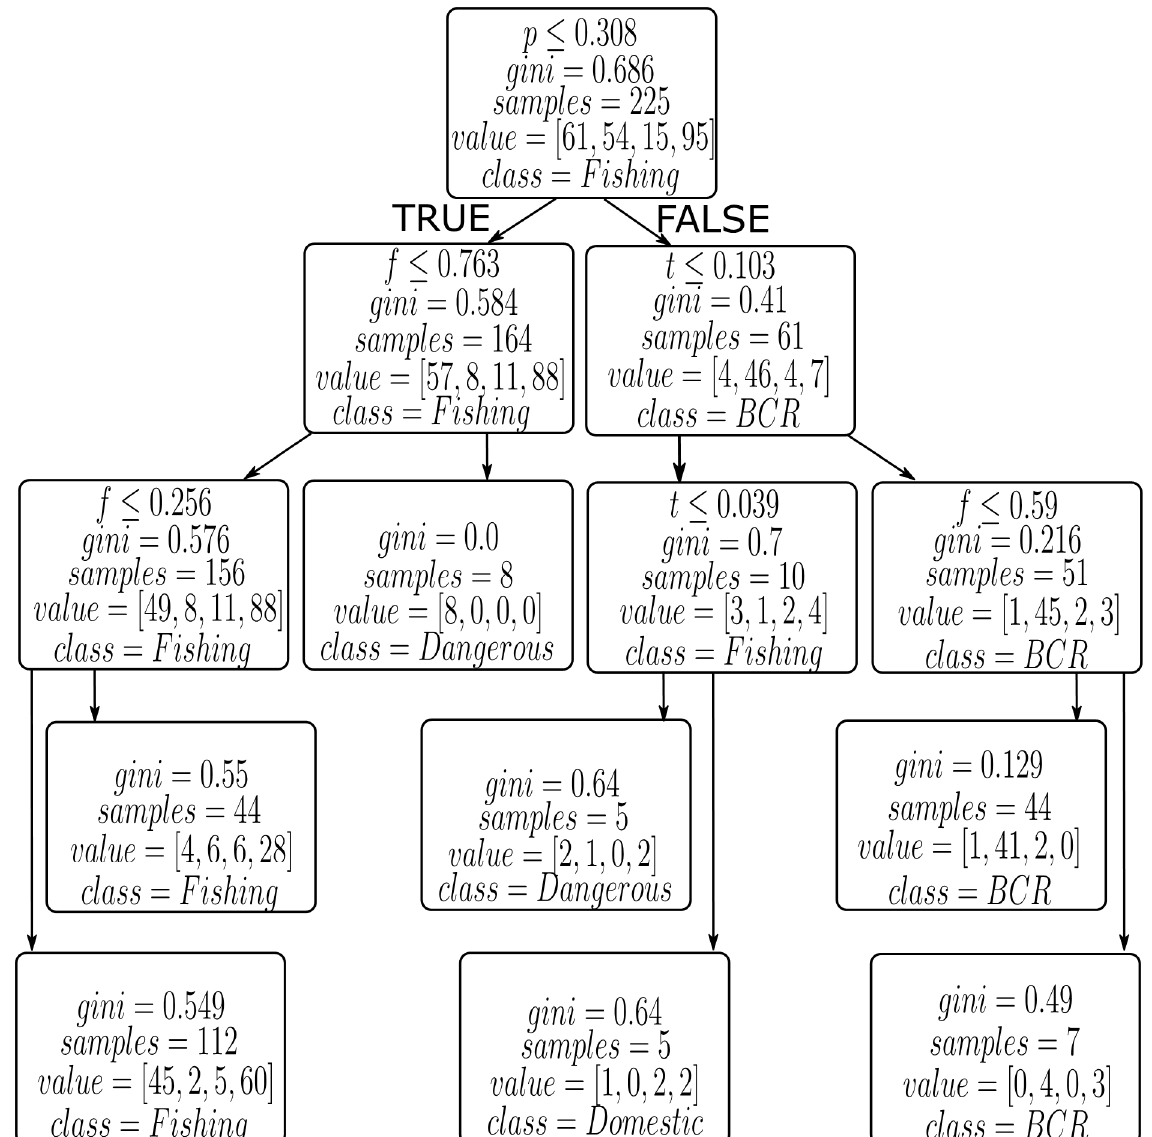
Figure 8. The Decision Tree developed using the CART algorithm. Level 1 has the root node. Level 2 and level 3 contain the decision nodes, and level 4 has the leaf nodes with data split into classes. The tree’s root node containing all 225 data points of our data set has been split based on the precipitation input variable (p) since p is the variable of the highest significance. The decision nodes at level 2 are split using the forest land use factor (f) and the temperature (t) input variables since these nodes repre- sent points of highest Gini impurity. At level 3, we get our first leaf node of class “Dan- gerous” with eight samples falling in this category (p ≤ 0.308, f ≥ 0.763). The final level contains the leaf nodes that classify the data into the specified classes. The class with the highest number of samples is fishing (156 samples), followed by BCR (51 samples). The classes “Domestic” and “Dangerous” have 5 and 13 samples, respectively, giving us a total of 225 samples in our data set. The CART algorithm is a moderately accurate method to classify our data set, giving an accuracy of 63.05% on the training set and 62.22% on the entire data set. However, improving our model using bagging and boosting methods yield even higher accuracies. From Table 2, CART with adaptive boosting gives the best testing accuracy out of all the decision trees. The adaptive boosting method enables to combine several weak classifiers into a strong classifier through an iterative decision tree